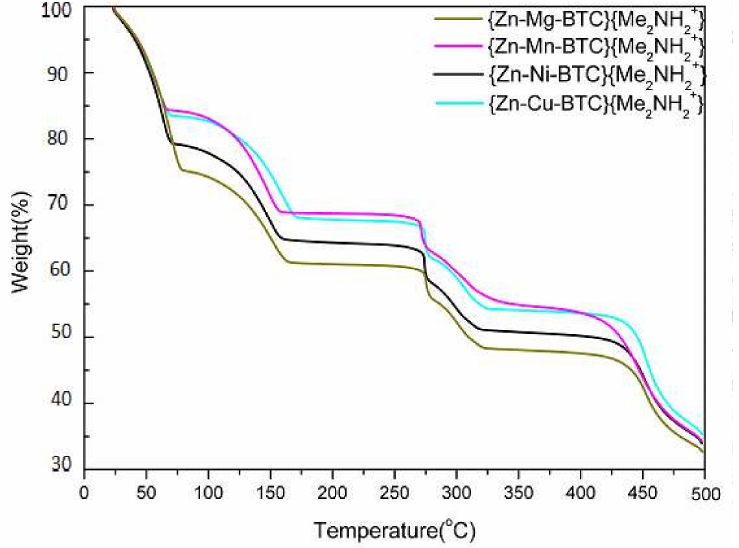
Figure 5. TGA curves of {Zn-M-BTC}{Me 2 NH 2 + } MOF (M = Cu, Ni, Mn,